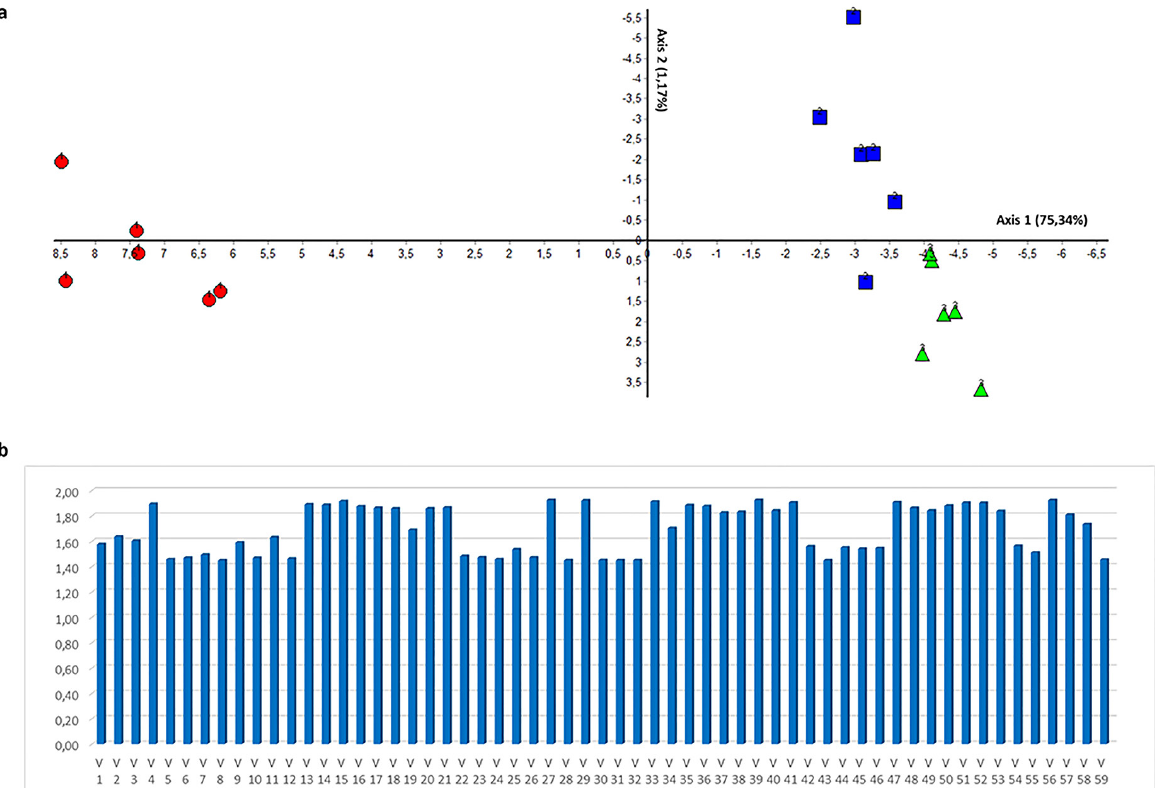
Figure 4. a. Principal component analysis. b. The relative contribution of the most important quantitative/ qualitative characteristics to the divergence between groups. Red circles: Foxn1 +/+ , blue squares: Foxn1 +/- , green triangles: Foxn1 -/-